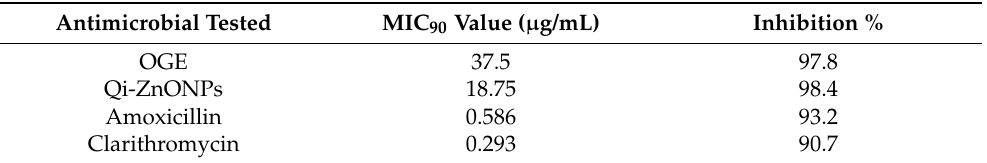
Table 3. The minimum inhibitory concentration (MIC) of different combinations of OGE/Qi-ZnONPs and the antibiotics against H. pylori (ATCC-43526) using a micro-dilutions method. Antimicrobial Tested MIC 90 Value ( µ g/mL) Inhibition % OGE 37.5 97.8 Qi-ZnONPs 18.75 98.4 Amoxicillin 0.586 93.2 Clarithromycin 0.293